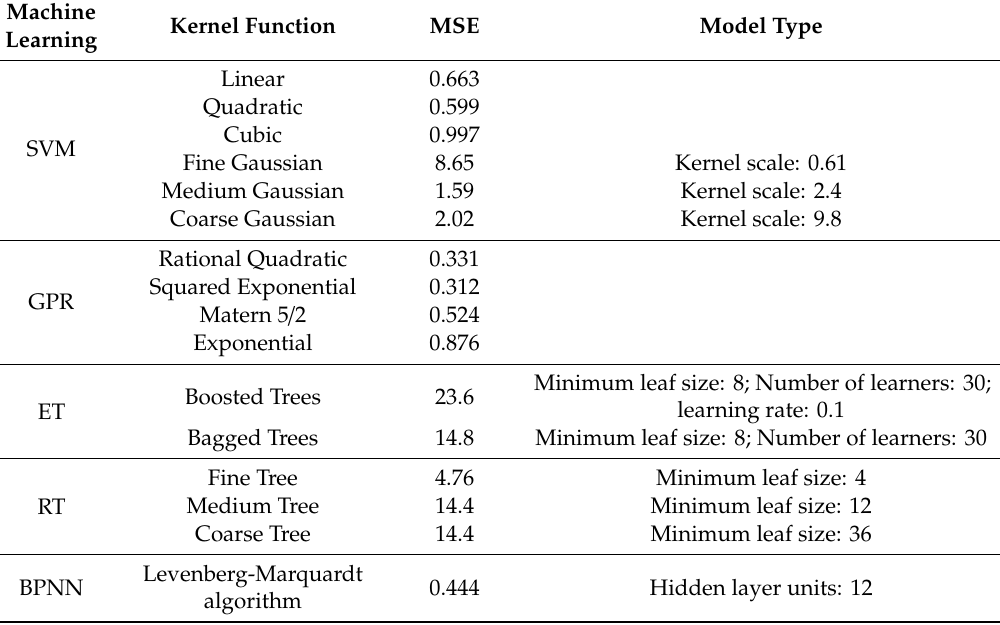
Table 3. Comparison of MSE values for five machine learning